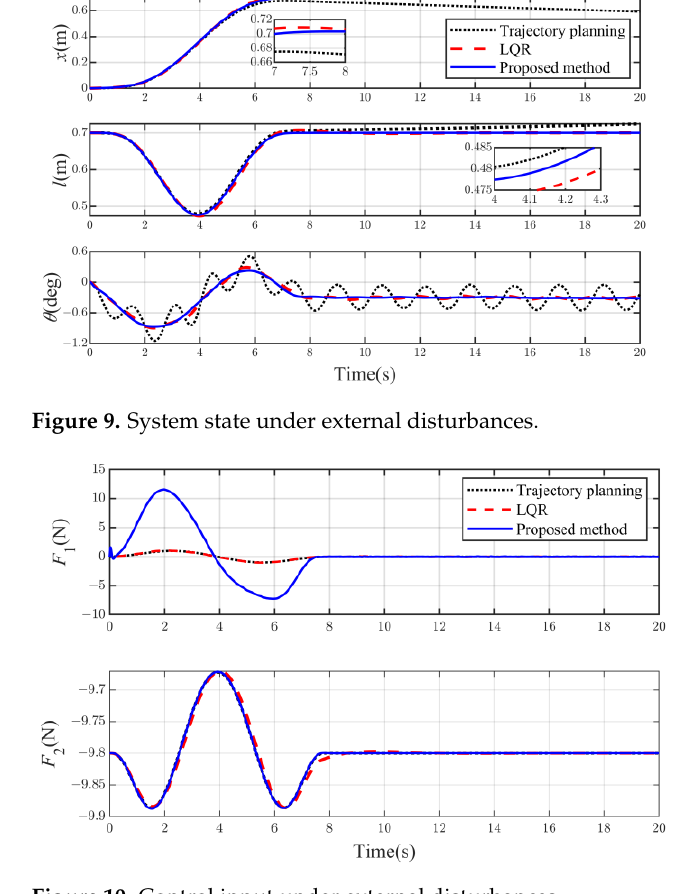
Figure 10. Control input under external disturbances.